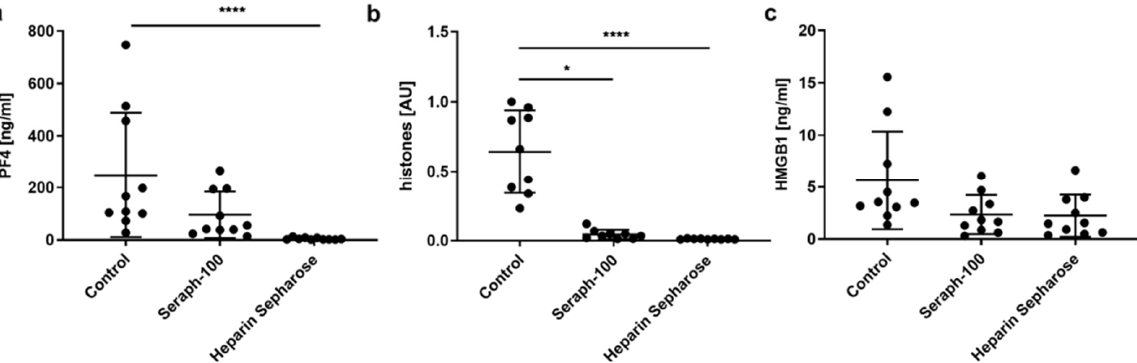
Figure 1. Depletion of PF4, histones/nucleosomes and HMGB1 by Seraph-100 and Heparin Sepharose. Plasma samples from sepsis patients were incubated with 10 vol% of adsorbent for 60 min at 37 °C and the remaining concentrations for ( a ) PF4, ( b ) histones/nucleosomes and ( c ) HMGB1 were determined. Plasma samples incubated without adsorbent served as controls. Data are presented as mean ± standard deviation (Kruskal–Wallis test followed by Dunn’s multiple comparisons; n = 9 for nucleosomes, n = 10 for HMGB1 and PF4; * p < 0.05, **** p < 0.0001). Results for histones/nucleosomes are given as arbitrary units (AU), which were calculated as a ratio of the highest optical density (OD) value and the OD value of individual samples.